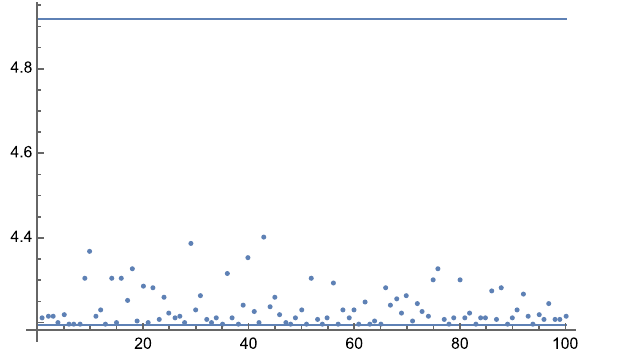
Fig. 17 The variances V [ F ] of Example 6 computed for 100 independent executions with the linear heuristic and using the first technique of Sect. 5.1 to sort out negative solutions. We use the same 100 samples from each technique as in Fig. 16. The horizontal lines correspond to the optimal and the equal sampling budget variances, respectively. Compare it with Figs. 16 and